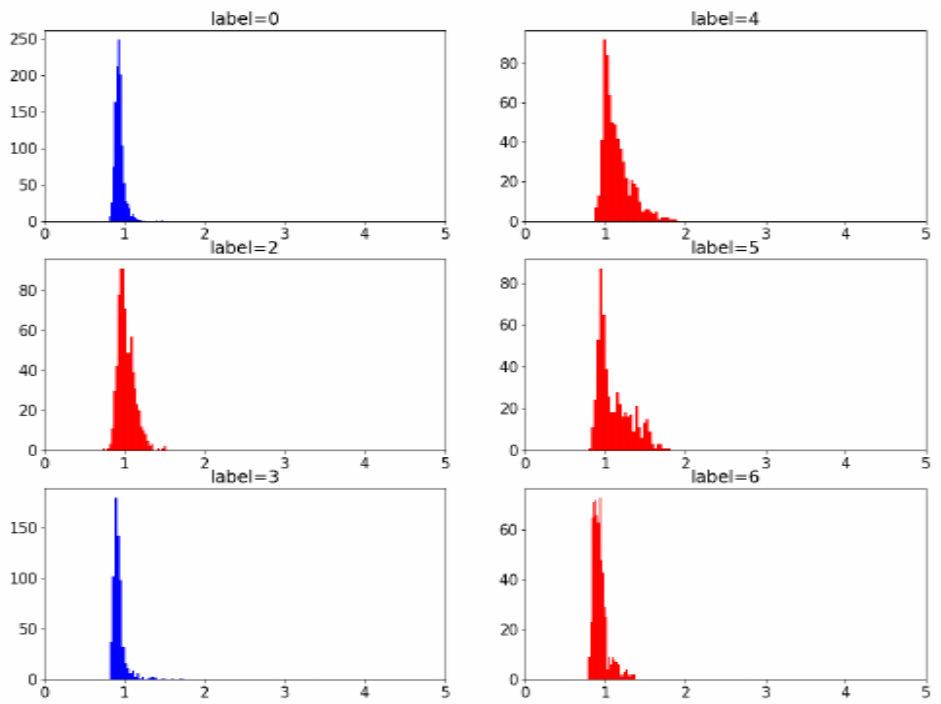
Figure 7. Rescaling task: Transfer-relevant (outlier) target instance histograms are depicted in red (blue). The figure is best viewed in color.